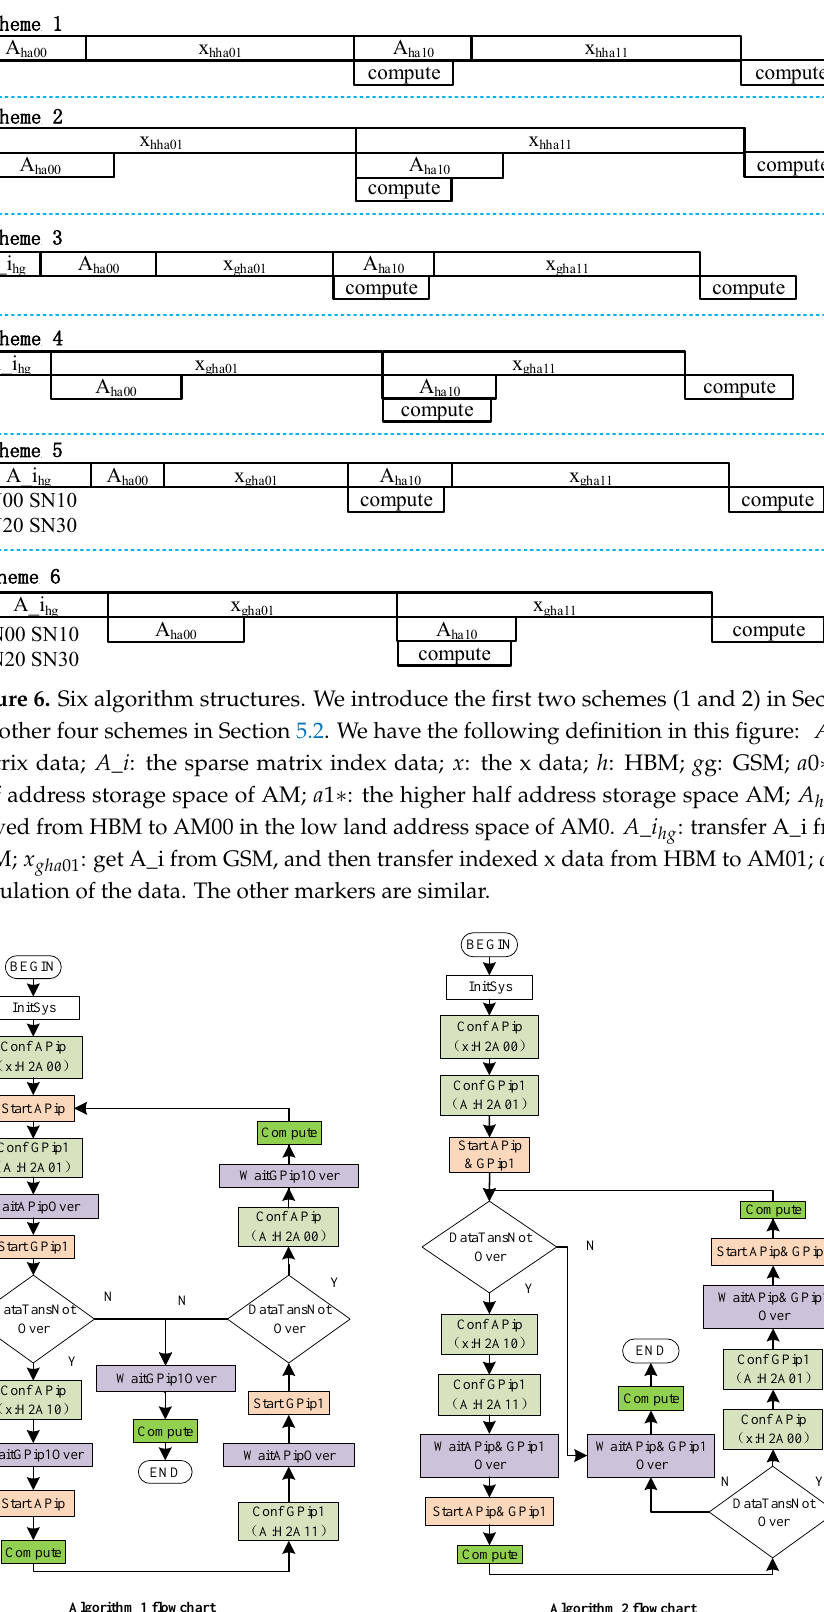
Figure 7. Flowchart for the two